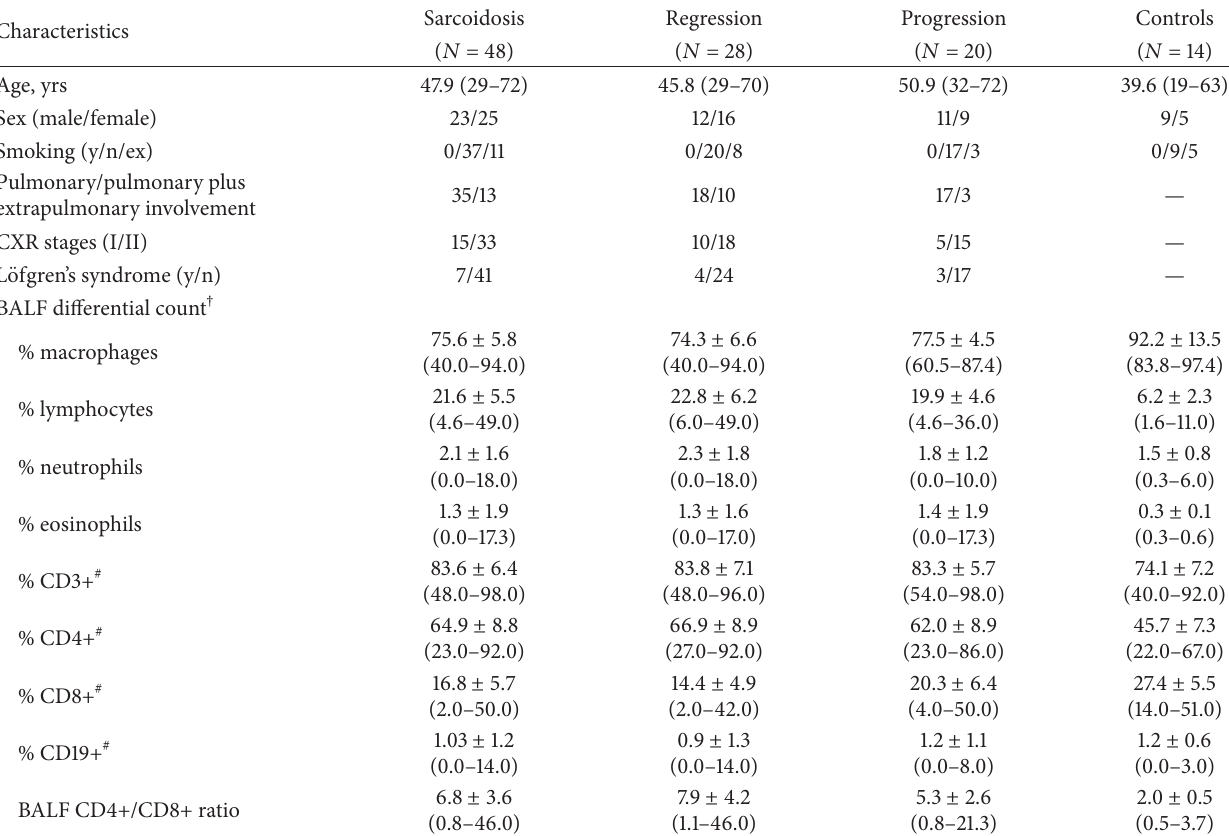
Table 1: Clinical and laboratory data of enrolled patients with pulmonary